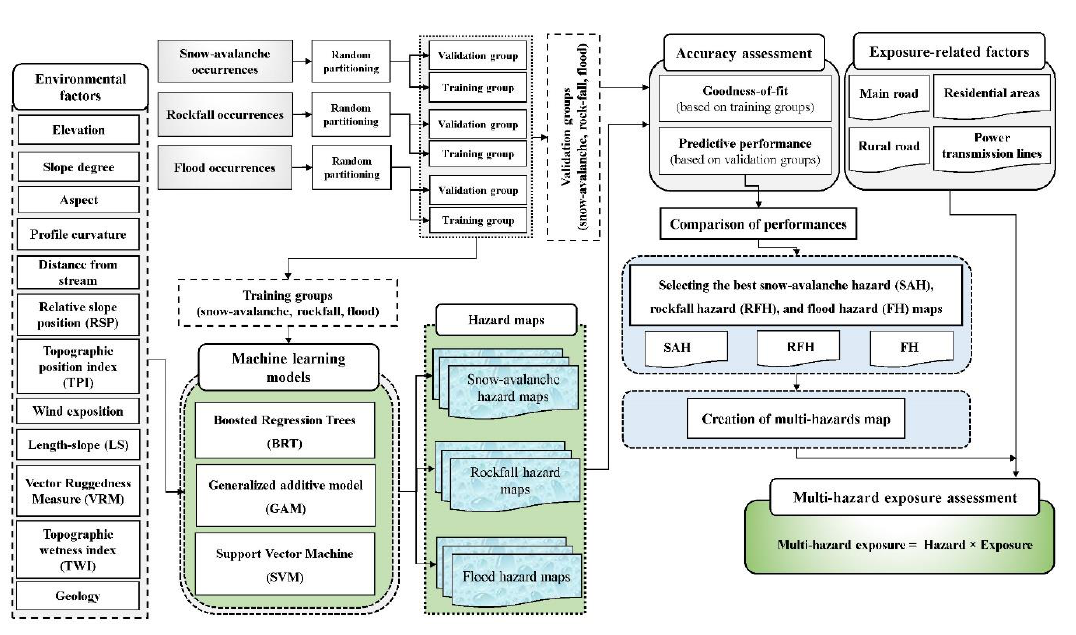
Figure 2. Methodology flowchart used in this study.